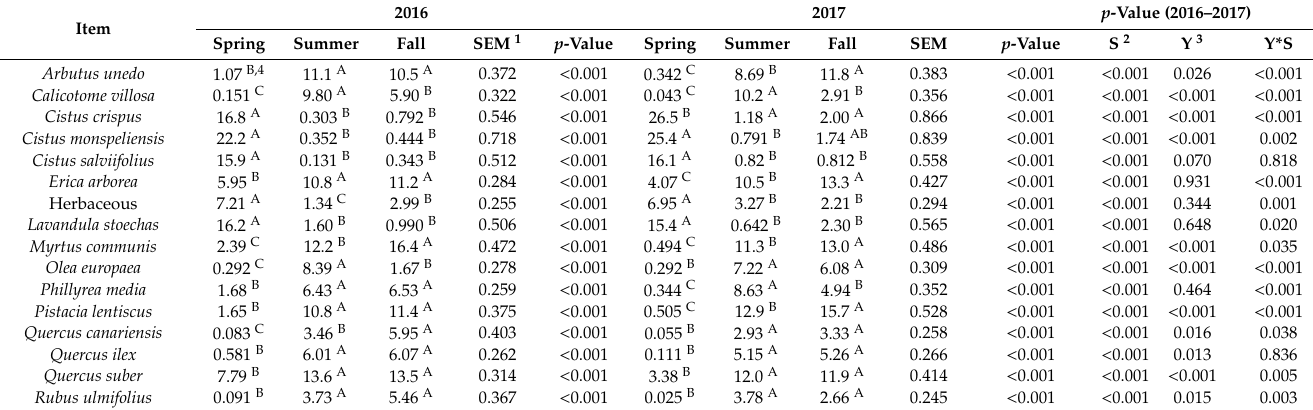
Table 4. Total bites (%) of goats browsing a Southern Mediterranean forest rangeland during 2016 and 2017.